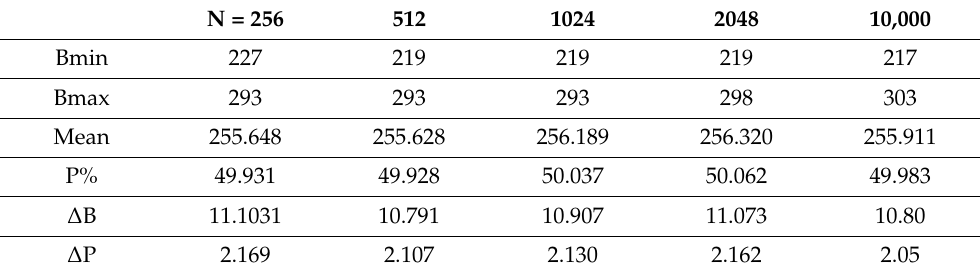
Table 10. Statically results for structure 2 for a number of different tests.